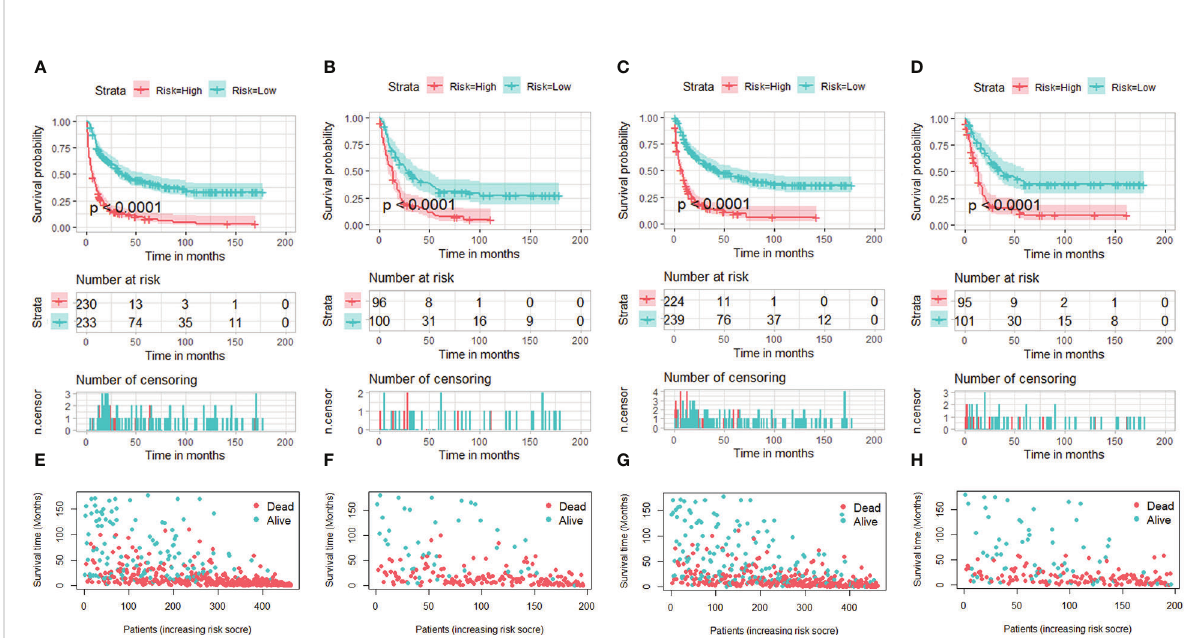
FIGURE 12 Kaplan – Meier survival curves of two mortality risk subgroups in the training set (part A , OS; part C , CSS) and testing set (part B , OS; part D , CSS). Kaplan – Meier survival status analysis for patients with STS with LNM in the training set (part E , OS; part G , CSS) and testing set (part F , OS; part H ,